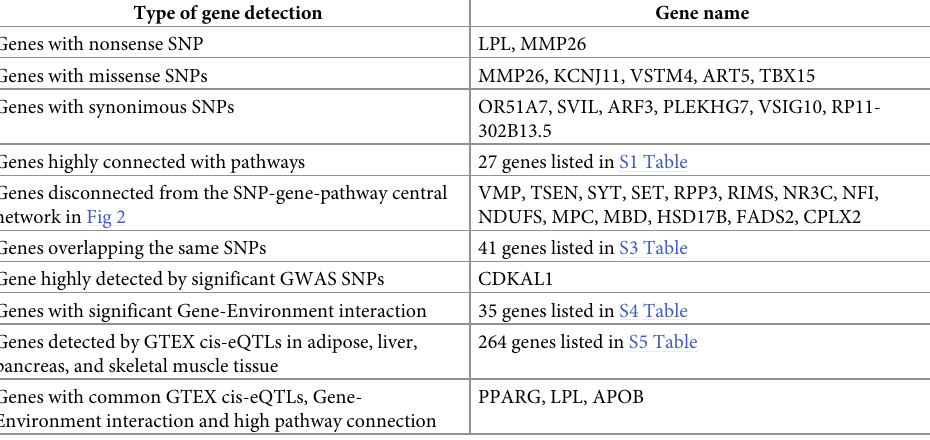
Table 1. Summary of the relevant genes detected in the secondary analysis of T2DM GWAS study. Type of gene